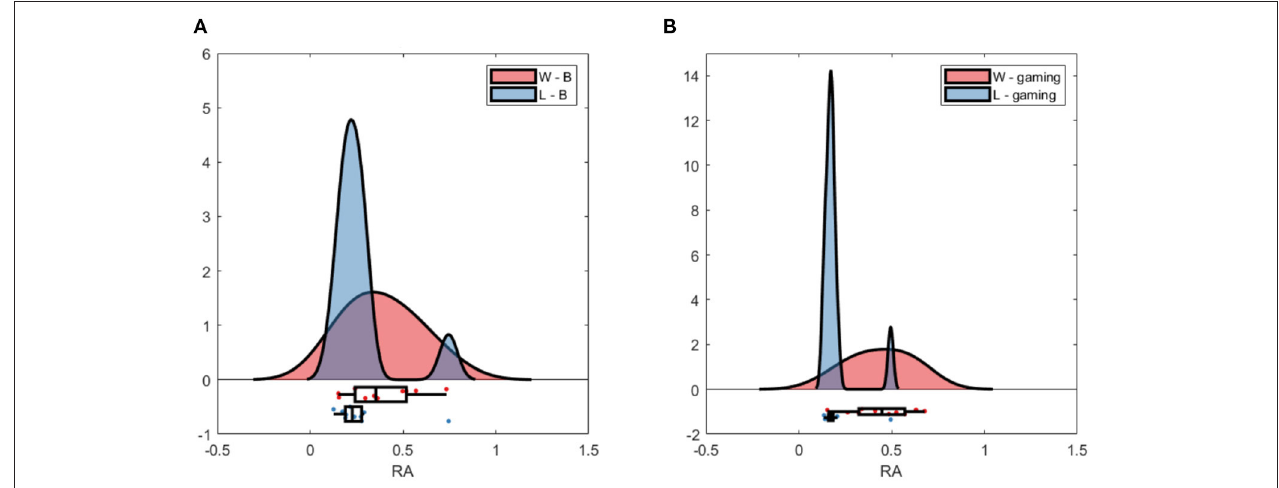
FIGURE 9 | Raincloud plot of relative alpha power at Pz; (A) baseline W (red) and L (blue); (B) gaming W and